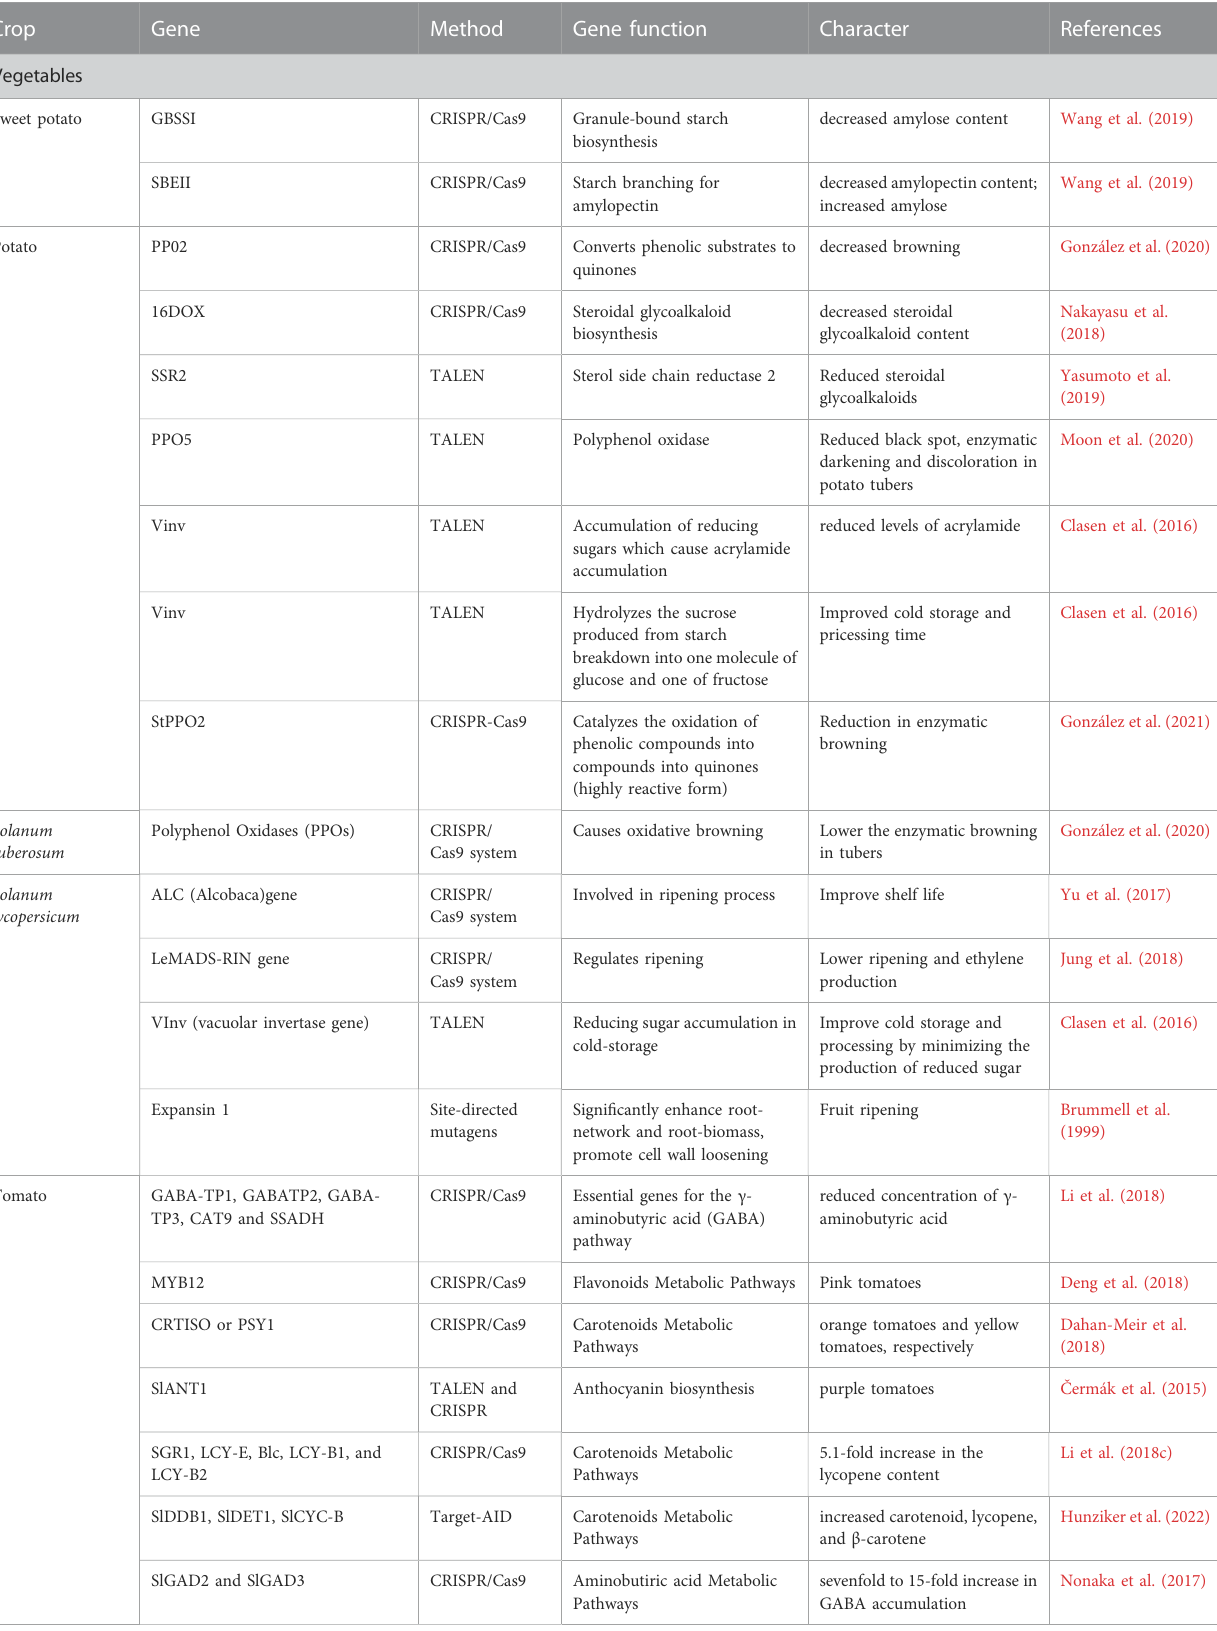
TABLE 1 List of the targeted genes that are modi fi ed by the CRISPR/Cas9 tool in fruits, vegetables, and ornamental plants.